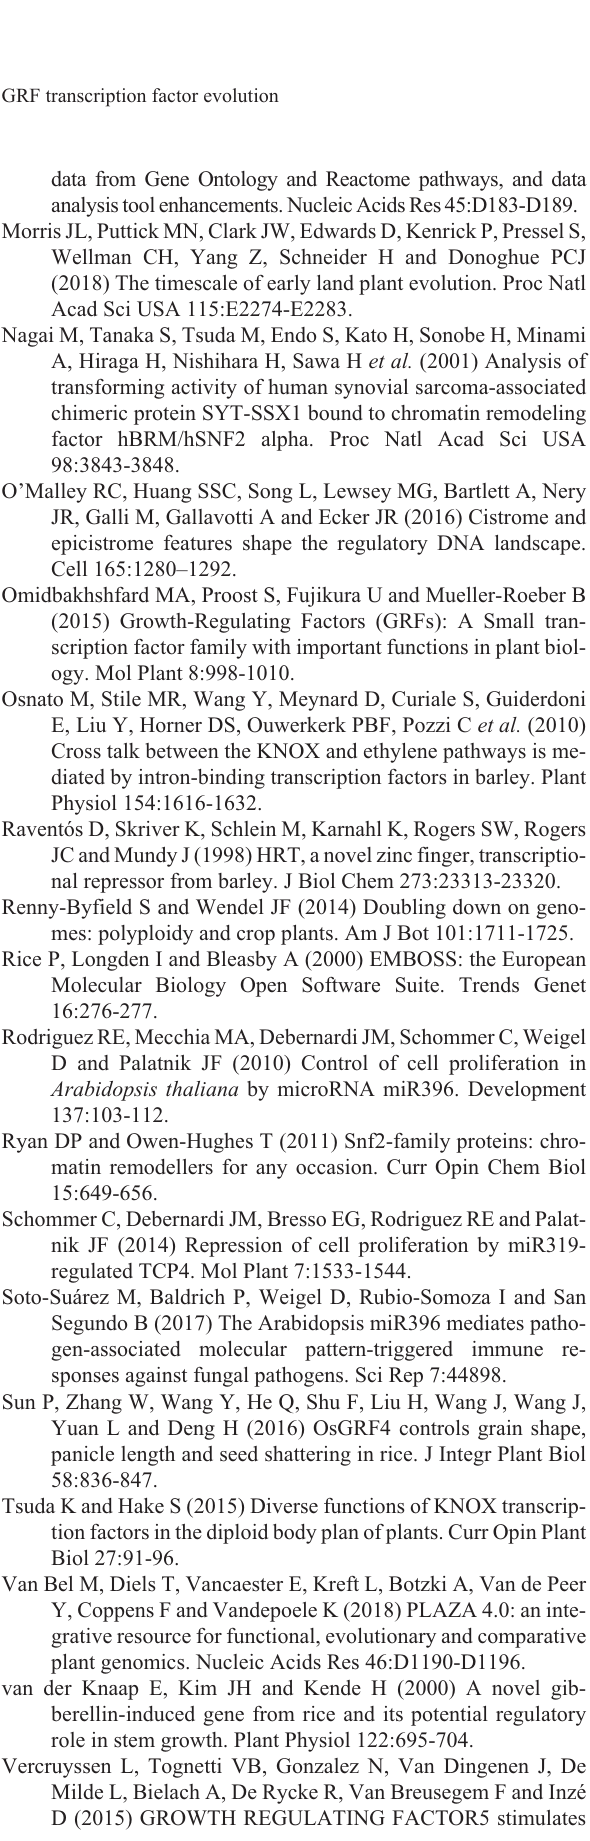
Table S1 – Species, loci and taxa terminologies of SNF2- type genes used in the